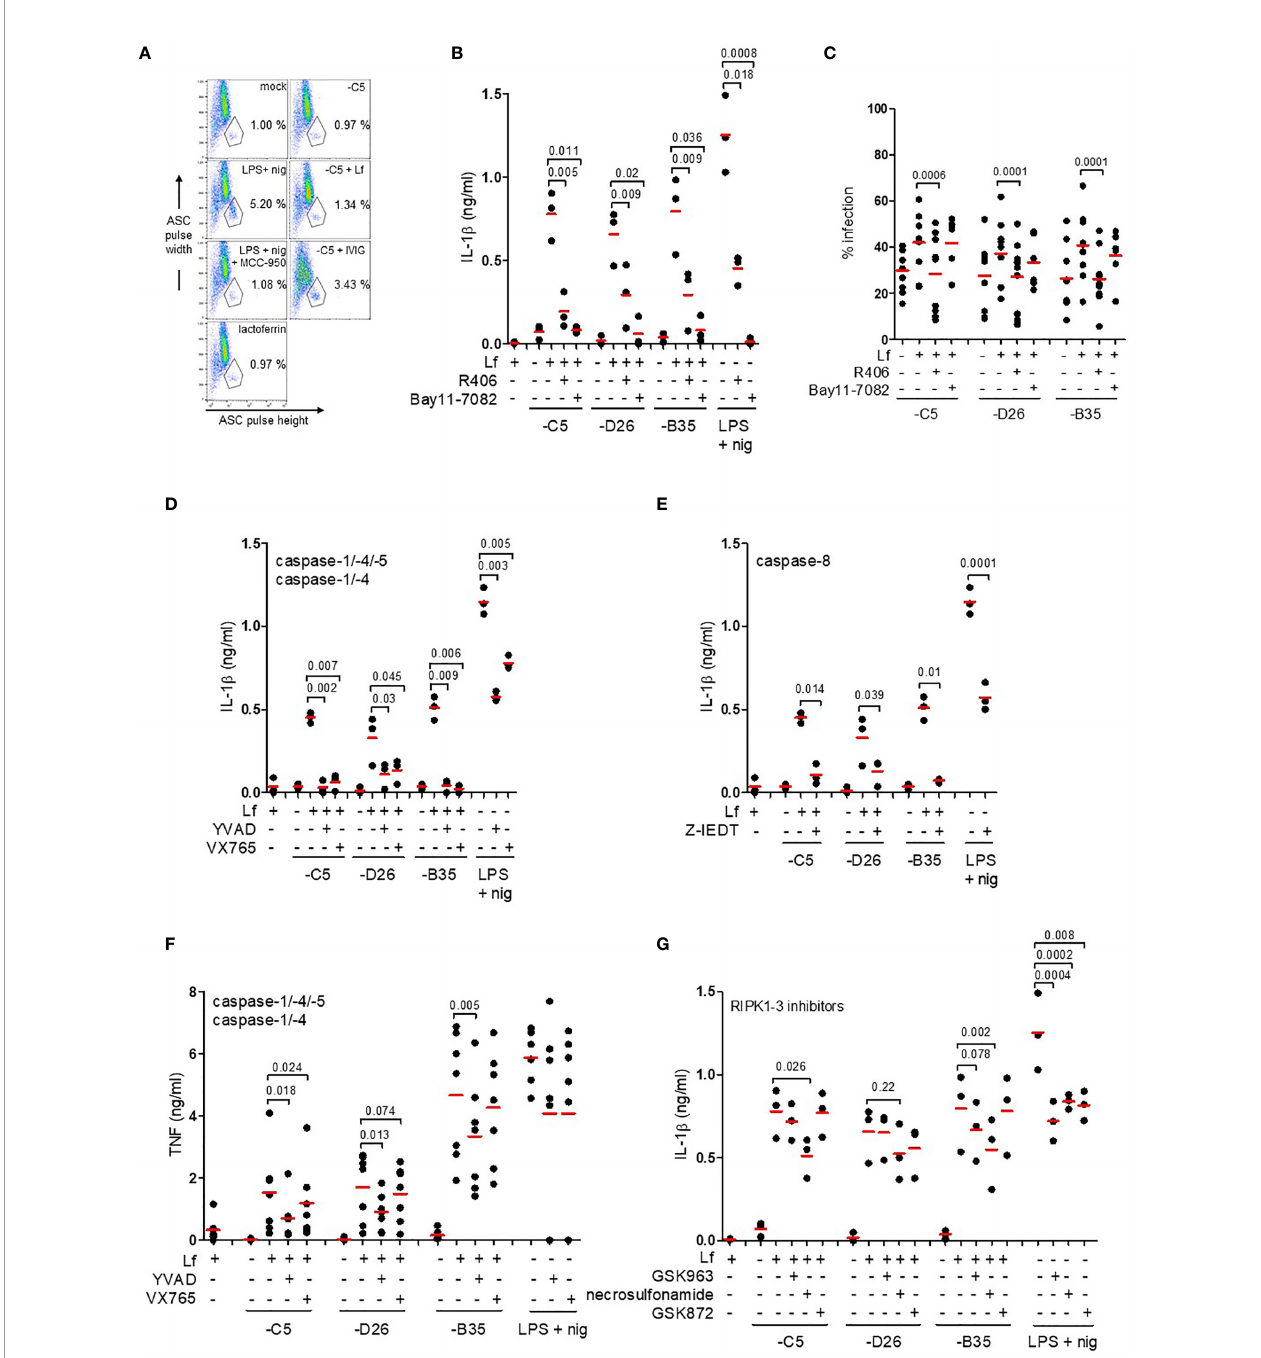
FIGURE 5 | IL-1 b release via an NLRP3 in fl ammasome and caspase-1. (A) Flow cytometry-based assay for ASC aggregation (pyroptosome formation): in fl ammasome formation was induced by incubating DCs with HAdV-C5-lactoferrin complexes for 3 h. LPS + nigericin and HAdV-C5-IVIG complexes were used as positive controls to identify in fl ammasome-positive cells. MCC-950 was used to inhibit NLRP3 in fl ammasomes. Lactoferrin was used as a negative control. Cells were stained with anti-ASC antibodies. In fl ammasome-positive cells were identi fi ed as ASC-width low and ASC-height high; (B) IL-1 b release in response to HAdV- lactoferrin complexes: DCs were pre-treated with R406 and Bay11-7082. LPS/nigericin was used as a positive control (n ≥ 3, statistical analyses by two-tailed paired t-test). (C) The percentage of infection of DCs by HAdV-lactoferrin complexes after pre-incubation of DCs with R406 and Bay11-7082. (D) Impact of caspase-1, -4, and -5 inhibition on IL-1 b release. (E) Impact of caspase-8 inhibition on IL-1 b release. (F) TNF release in response to HAdV-lactoferrin complexes in DCs pre-treated with YVAD or VX765. (G) IL-1 b release in response to HAdV-lactoferrin complexes in DCs pre-treated with RIPK1-RIPK3 pathway inhibitors GSK963, necrosulfonamide or GSK872. N ≥ 3 in all assays. Statistical analyses by two-tailed paired